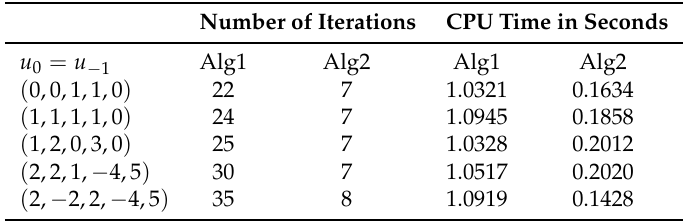
Table 4. Example 2: Algorithm 1’s numerical comparison with Algorithm 1 in [19].